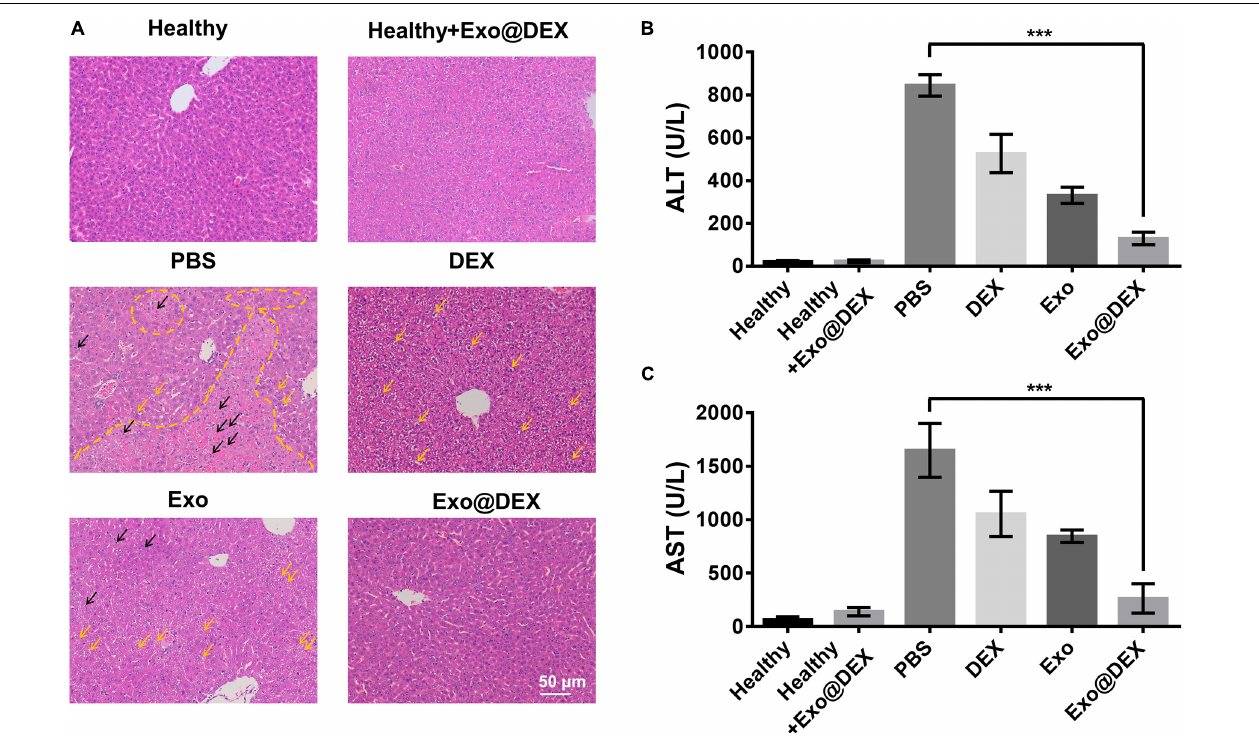
FIGURE 4 | In vivo treatment of the Con A-induced AIH mouse model. (A) H&E staining of liver sections from different groups 8 h after Con A injection and treatment. Black arrows indicate inflammatory cells. Yellow arrows indicate steatosis, suggesting mild damage to livers. The yellow line indicates large hemorrhage, suggesting severe damage. (B,C) Serum levels of ALT and AST were measured 8 h after Con A injection and treatment ( n = 5 for each group). Data in B and C are presented as the mean ± SD and were assessed via one-way ANOVA (*** P < 0.001).